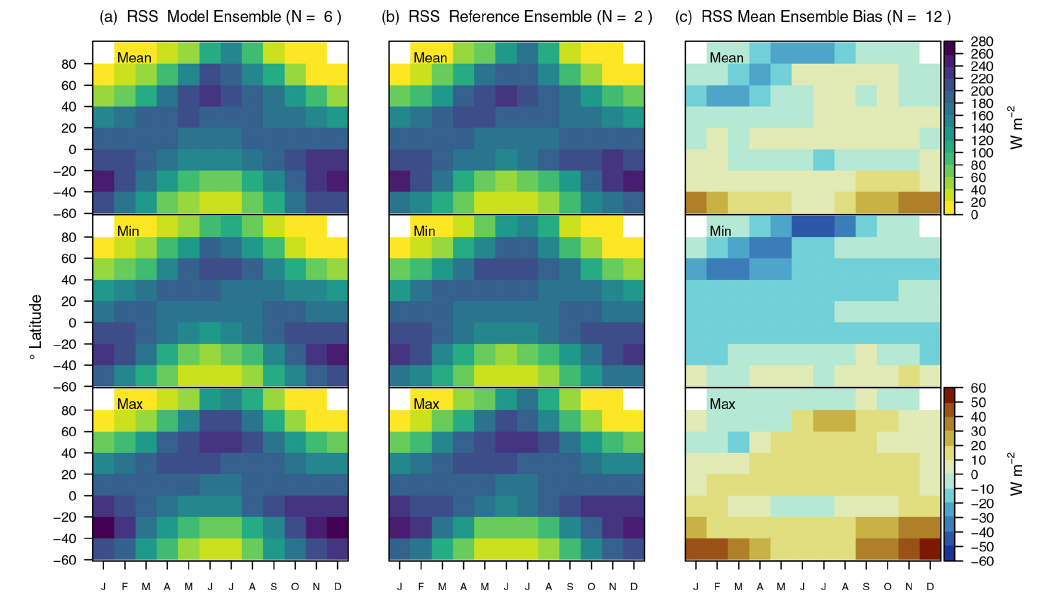
Figure A4. Same as in Fig. 8 but for net SW